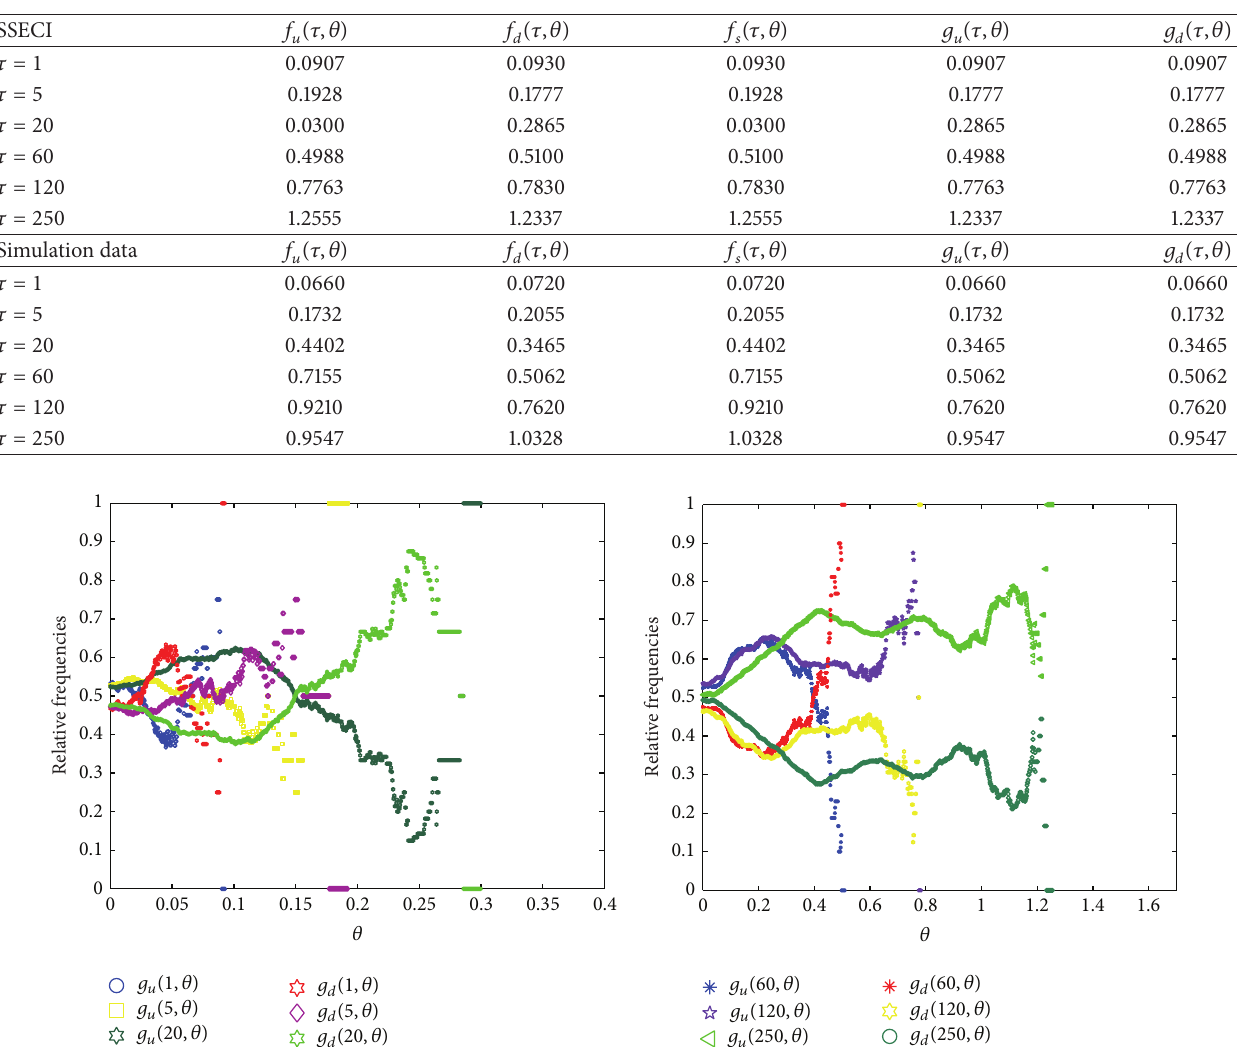
Table 1: The values of the inflection points.